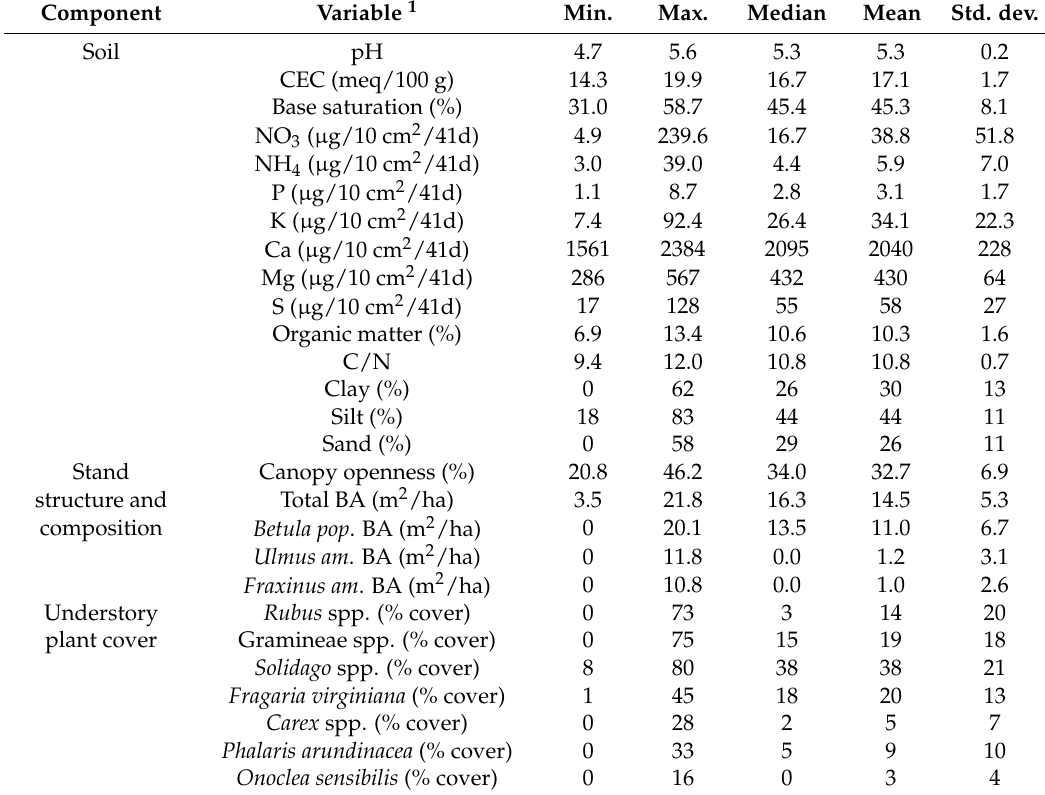
Table A1. Descriptive statistics for the ecological variables measured across all blocks. For each variable, descriptive statistics where obtained from block averages (N = 25